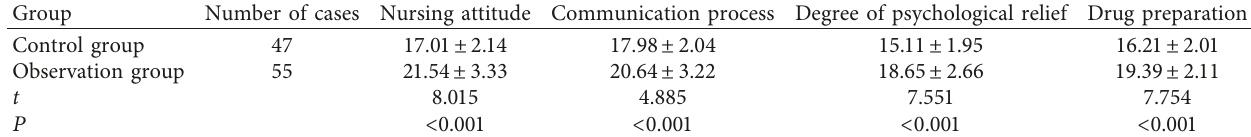
Table 6: Comparison of two patients’ satisfaction ( n ,